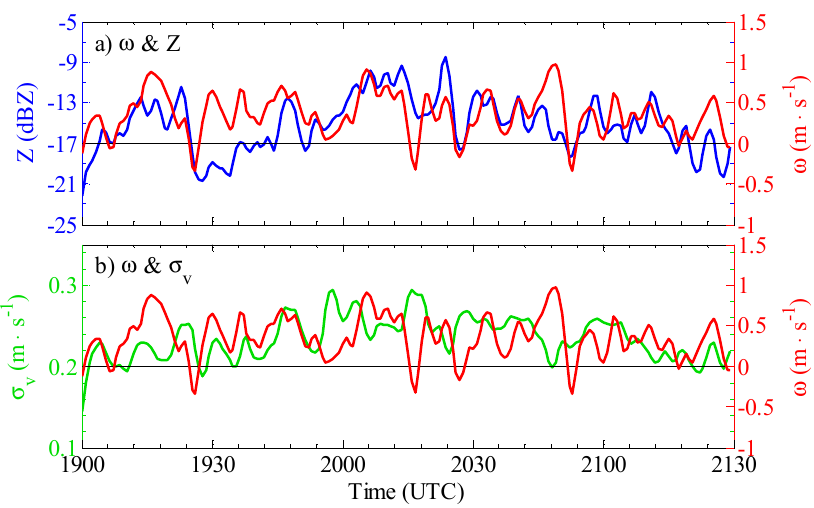
Figure 7. Height-average curves of the Z (blue curve), σ v (green curve), and ω (red curve); ( a ) is the changing curves of ω and Z; ( b ) is the changing curves of ω and σ v .